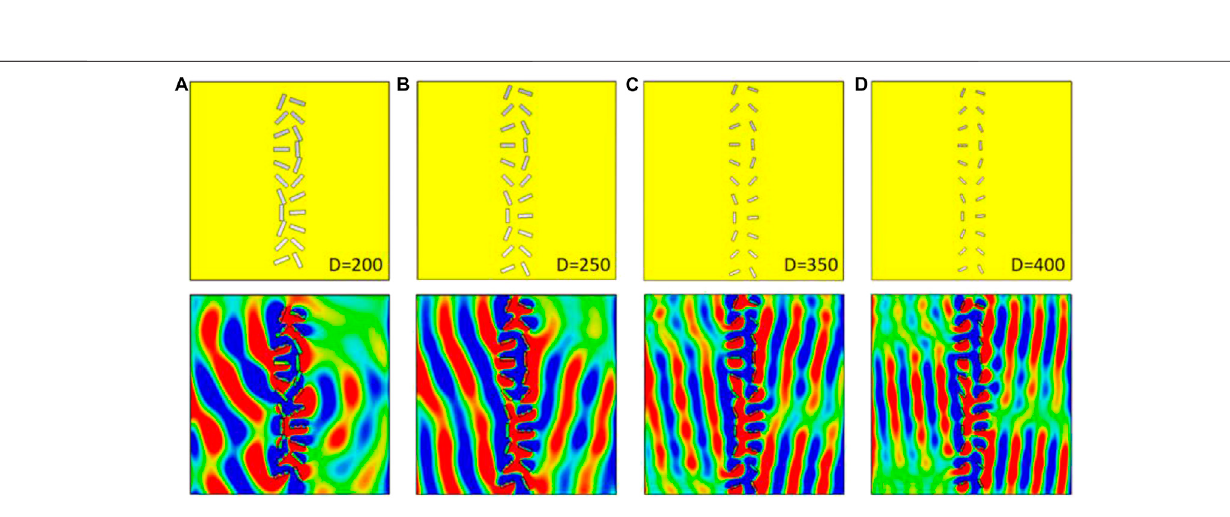
Frontiers in Physics |